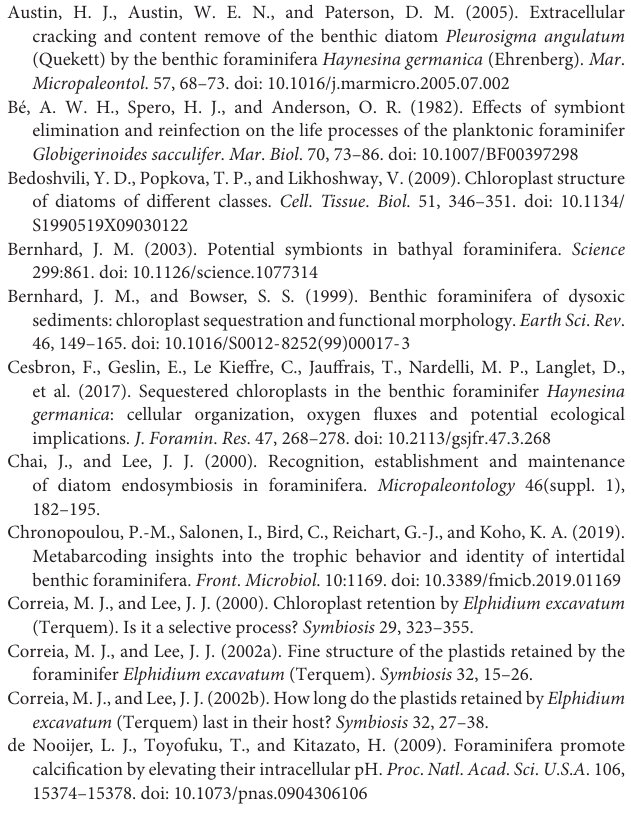
FIGURE S3 | Capture of diatom within the Planoglabratella opercularis pseudopodial network. Live diatom cells were drawn toward the foraminiferal cell (arrowheads), leaving diatom frustules behind (arrow). Scale bar = 100 µ m. FIGURE S4 | Transmission electron micrographs (TEMs) of unfed cultures of Planoglabratella opercularis . TEMs indicate ultrastructural changes among P. opercularis cultured for (A,B) 0, (C,D) 2, or (E,F) 11 days without food. Kleptoplast ( ∗ ), food vacuoles (fv), lipid (l), mitochondria (m), and nucleus (n). Scale bar = 2 µ m (A,C,F) ; 500 nm (B) ; 1 µ m (D) ; 5 µ m (E) . FIGURE S5 | Transmission electron micrographs (TEMs) of Planoglabratella opercularis cultures fed with heat-killed Chlorella . TEMs indicate ultrastructural changes between P. opercularis fed heat-killed Chlorella cultured for (A,B) 2 or (C–F) 11 days. Intact kleptoplast ( ∗ ), scale bar = 2 µ m (A) , 1 µ m (B) . (C) Degraded kleptoplast (k). Scale bar = 2 µ m. (D) Numerous heat-killed Chlorella in food vacuoles (fv), lipid (l). Scale bar = 2 µ m. (E) . Magnified degraded kleptoplast in (C) . Thylakoids are clearly visible but outer membranes are degraded. Scale bar = 1 µ m. (F) Thylakoid membranes and stroma are discretely situated. Scale bar = 1 µ m. FIGURE S6 | Transmission electron micrographs (TEMs) of Planoglabratella opercularis cultures fed live Chlorella . TEMs indicate the ultrastructural differences among P. opercularis fed live Chlorella cultured for (A,B) 2 or (C–F) 11 days. Nucleus (n), kleptoplast ( ∗ ), lipid (l), mitochondria (m), food vacuole (fv). Chlorella (ch), cell wall of captured Chlorella (arrowheads). (A) Scale bar = 5 µ m.